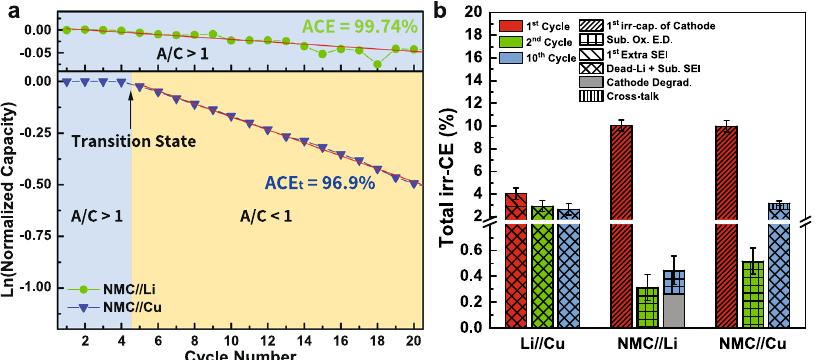
Fig. 6 Results obtained from integrated protocol using 1 M LiPF 6 in EC:DEC (1:1) with 5% FEC added as electrolyte under the current density of 0.2 mA cm − 2 . a Normalized discharge capacity versus cycle number of NMC/Li and NMC/Cu cells. b irreversible CE comparison of Li/Cu, NMC/Li, and NMC/Cu cells. Error bars represent standard deviation, n = 3 independent replicates. The capacity retention comparison of NMC/Li and NMC/Cu cells are shown in Supplementary Fig. 8c. The charge/discharge pro fi les of each cell con fi guration are shown in Supplementary Fig.